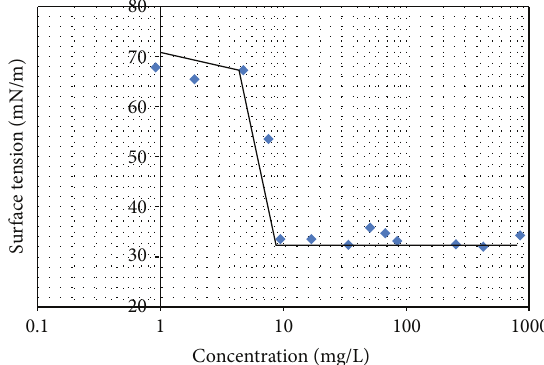
Figure 2: Minimum surface tension and critical micelle concentra- tion of SLJO.